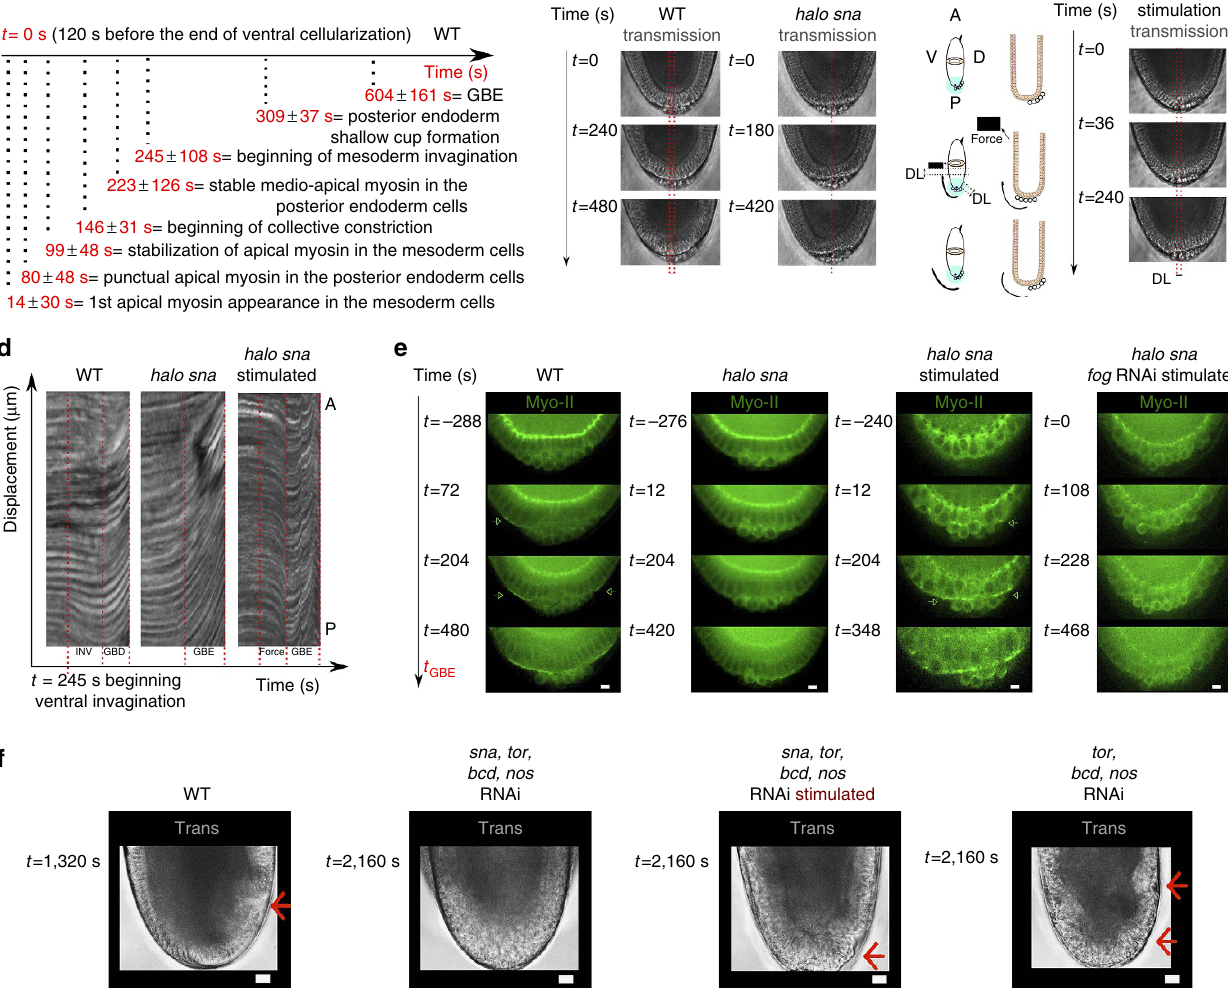
Figure 6 | Fog-dependent induction of endoderm apical Myo-II by mesoderm invagination. ( a ) Timing of the sequence of morphogenetic events at gastrulation. ( b ) Stretching of posterior endoderm cells by mesoderm invagination in the WT, followed by compression by GBE. Such stretching is shown to be absent in halo sna mutants. Representative of the N ¼ 6 embryos observed in each case. ( c ) Mechanical rescue of posterior endoderm stretching by highly localized magnetic interactions with UML-loaded mesoderm in halo sna mutants. ( d ) Chemographs of the posterior endoderm of WT, halo sna and magnetically stretched halo sna . Representative of the N ¼ 6 embryos observed in each case. ( e ) Distribution of Myo-II-GFP in sqh-GFP, halo sna sqh-GFP, halo sna sqh-GFP magnetically stretched posterior endoderm, and Fog RNAi-injected halo sna sqh-GFP magnetically stretched posterior endoderm. Representative of the N ¼ 6 WTembryos, the N ¼ 6 halo sna embryos P ¼ 2 (cid:3) 10 (cid:2) 3 , exact Fisher test), the N ¼ 14 halo sna stretched embryos ( P o 10 (cid:2) 3 ) and the N ¼ 7 halo sna Fog RNAi-stimulated embryos ( P o 10 (cid:2) 3 ). Scale bars, 5 m m. ( f ) Invagination (red arrow) in the posterior endoderm of non Rnai- injected (representative of the N ¼ 6 embryos observed), sna, bcd, nos, tor Rnai-injected (representative of the N ¼ 4 embryos observed, P ¼ 2 (cid:3) 10 (cid:2) 3 ), sna, bcd, nos, tor Rnai magnetically stretched posterior endoderm (representative of N ¼ 5/8 embryos, P ¼ 0.02), and bcd, nos, tor Rnai embryos ( N ¼ 4, P ¼ 0.03). Scale bars, 10 m m.